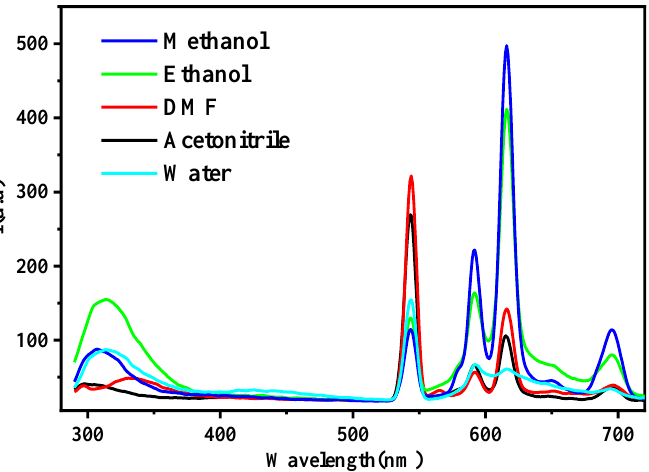
Figure 3. The luminescence spectra of the 2.5 × 10 − 5 mol · L − 1 Eu (III)–(vitB1) 2 complex in various solvents, with the λ ex = 268 nm, at room temperature.